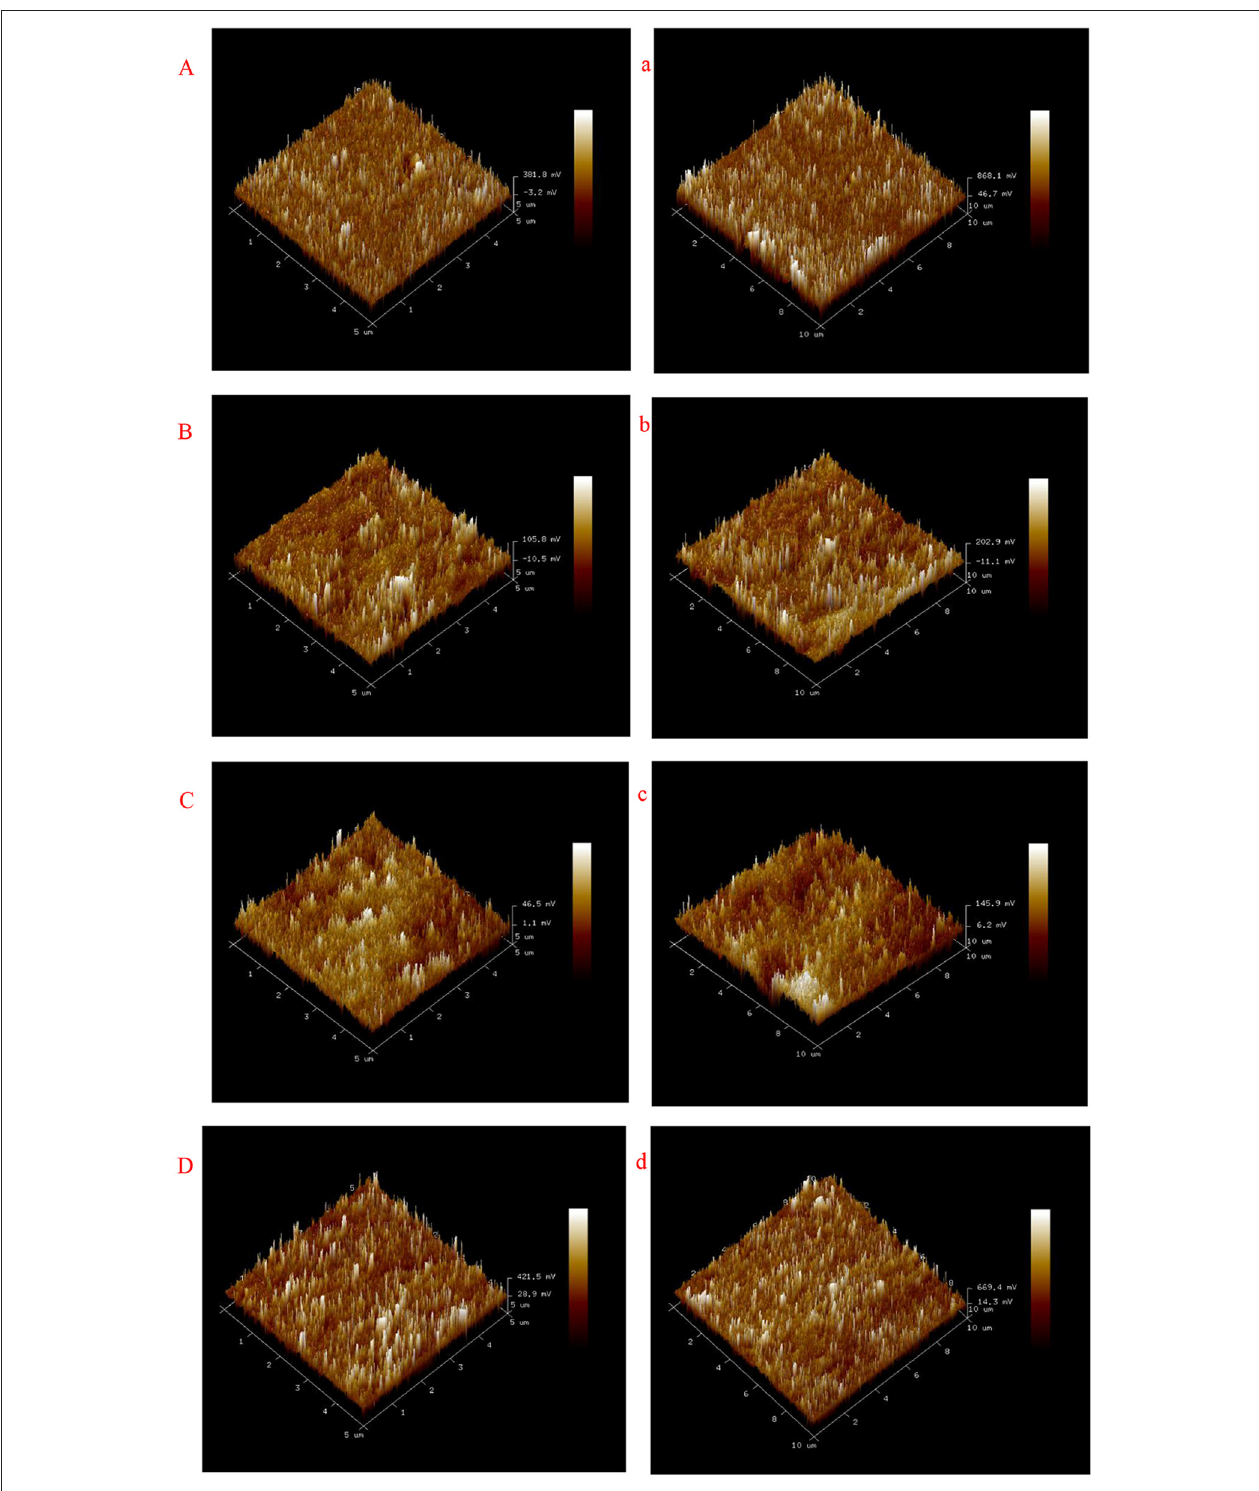
FIGURE 1 | Typical atomic force microscopy (AFM) images of cassava starch-based films (5 and 10 µ m): (A) Control (5 µ m), (B) 0.5% (5 µ m), (C) 1% (5 µ m), and (D) 2% (5 µ m), (a) Control (10 µ m), (b) 0.5% (10 µ m), (c) 1% (10 µ m), and (d) 2% (10 µ m).